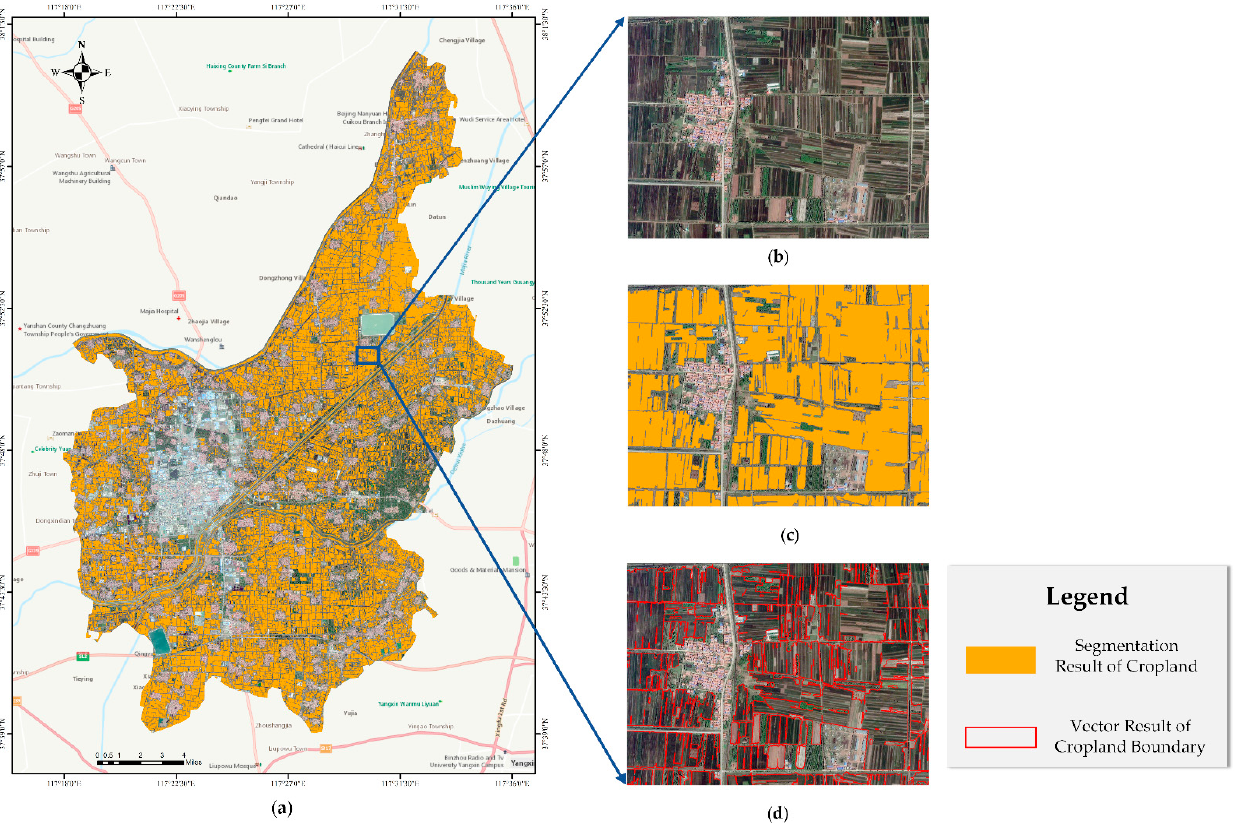
Figure 13. Large-area cropland extraction result in Qingyun County, Dezhou City, Shandong Province. ( a ) The cropland result extracted from the mosaic image of Qingyun County, ( b ) the true-color image within the blue box in ( a ), ( c ) the cropland result of ( b ), and ( d ) the vector result of the cropland boundary.